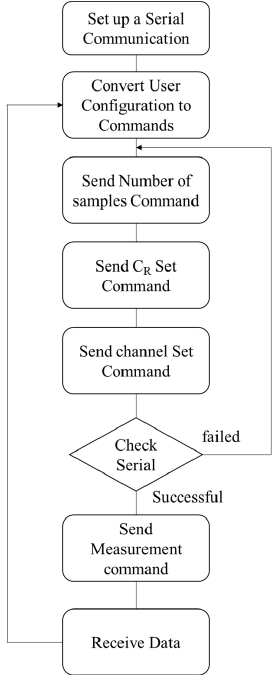
Figure 13. The flowchart of the GUI data acquisition from the Microcontroller: After a serial connec- tion is set up between the GUI and the microcontroller, the user can input all the settings shown in Figure 12a. The GUI generates three commands based on the user settings and sends them to the microcontroller. Then, the serial port is checked again before establishing the measurement com- mand on the serial port. Next, the data is received from the chip and read from the microcontroller’s SPI port buffer.